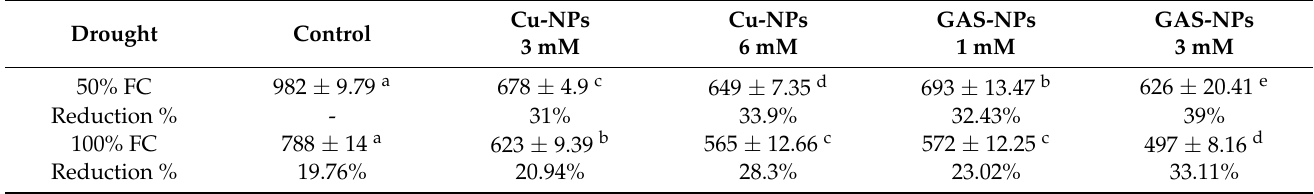
Table 1. Mean accumulative number of T. urticae on soybean plants in response to Cu-NPs and GA-NPs during the successive growing seasons of 2020–2021 under normal and drought stress.